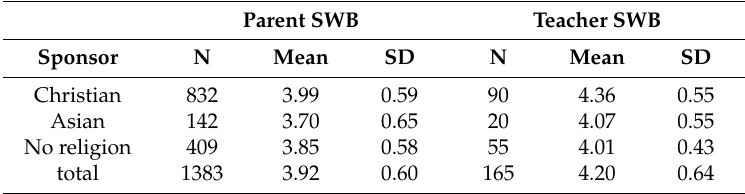
Table 5. Mean (SD) values for influence of Sponsor on parents’ and teachers’ SWB.